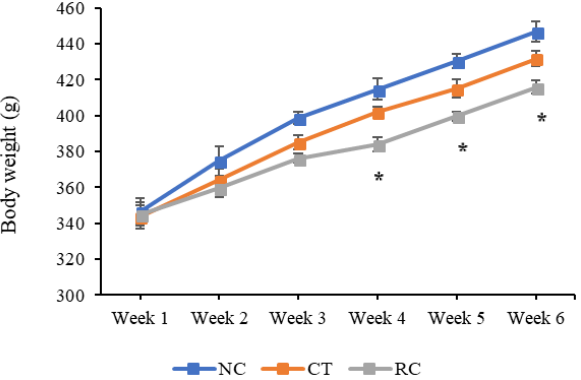
Figure 6. Change in average body weights. Shown are the changes in body weights in the normal control (NC), chitosan (CT) and RGD−Chitosan conjugate (RC) groups. The NC and the RGD−CT groups show significant changes after 4 weeks of treatment (*: p < 0.05, n =